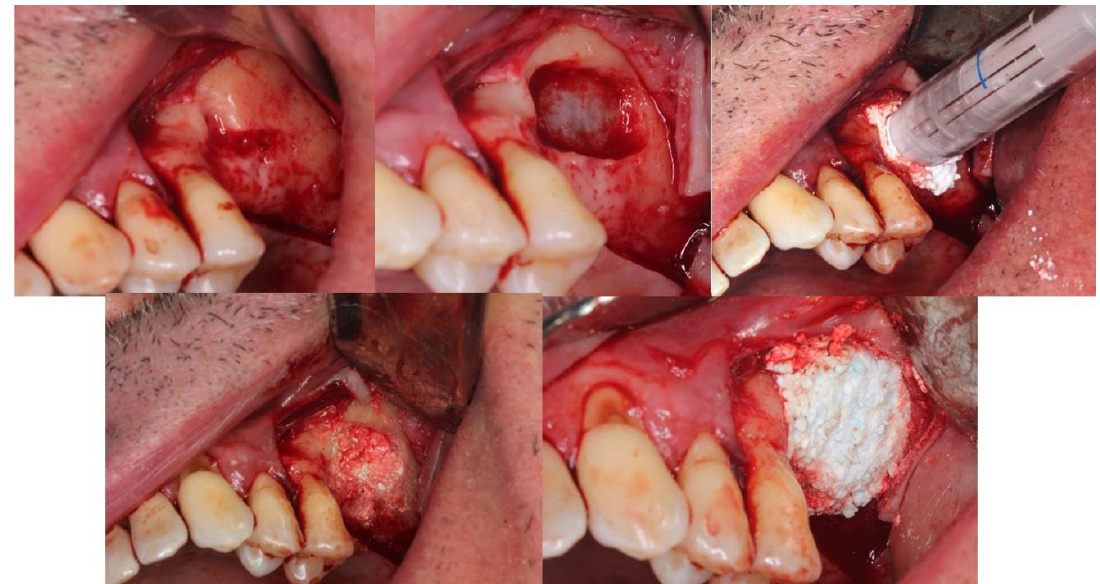
Figure 19. Intraoperative photographs.